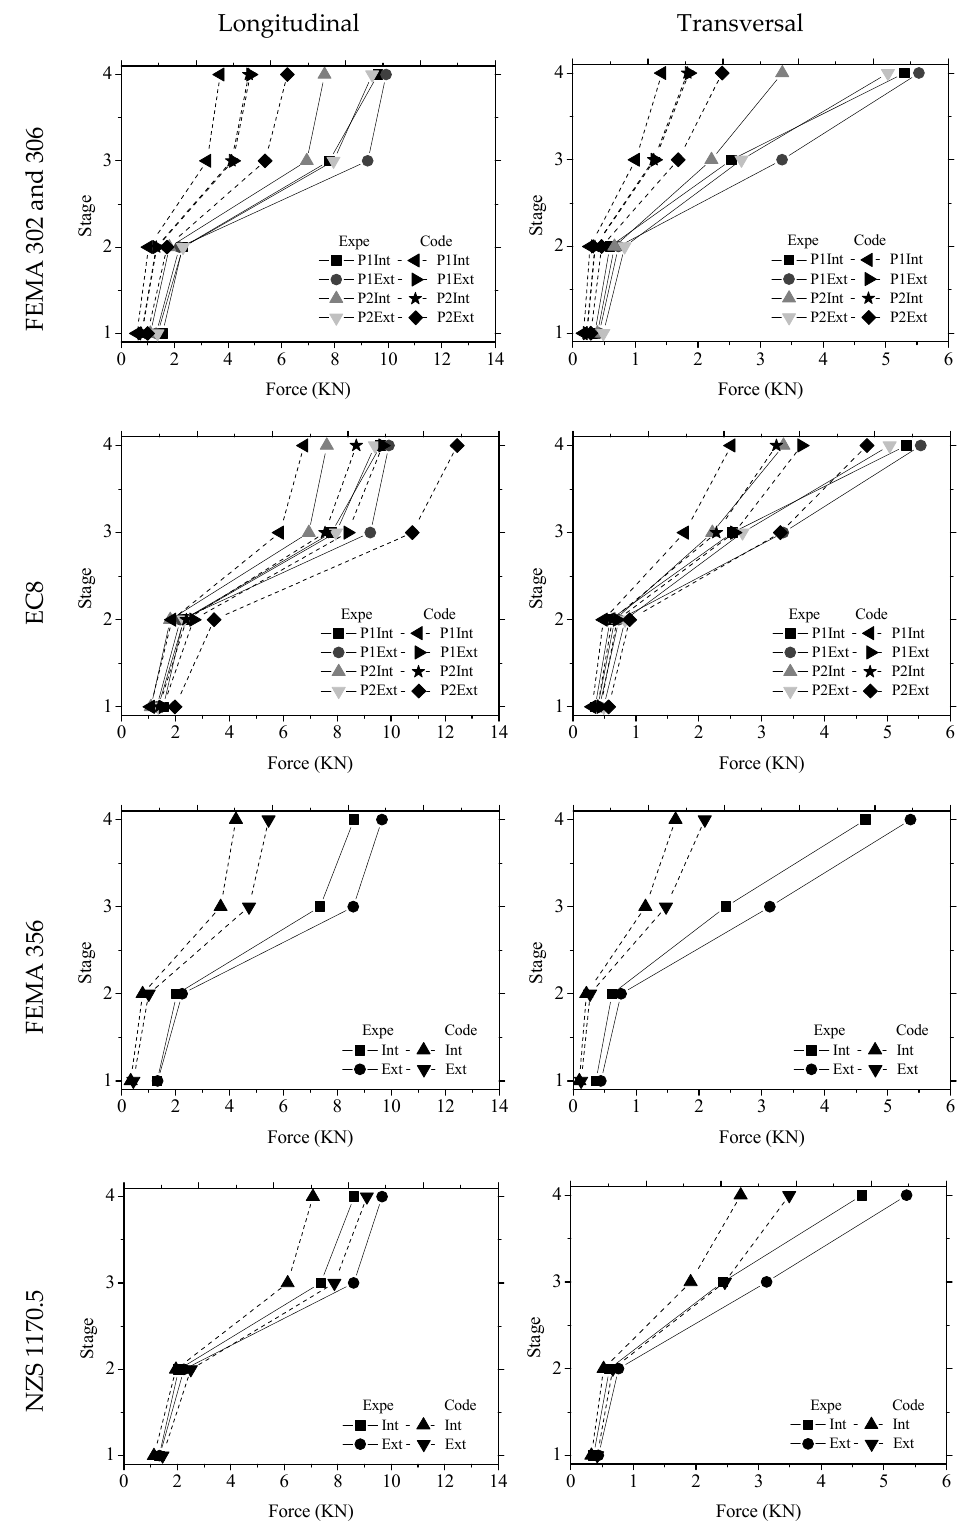
Figure 10. Standard and experimental out-of-plane load comparison for model 1.